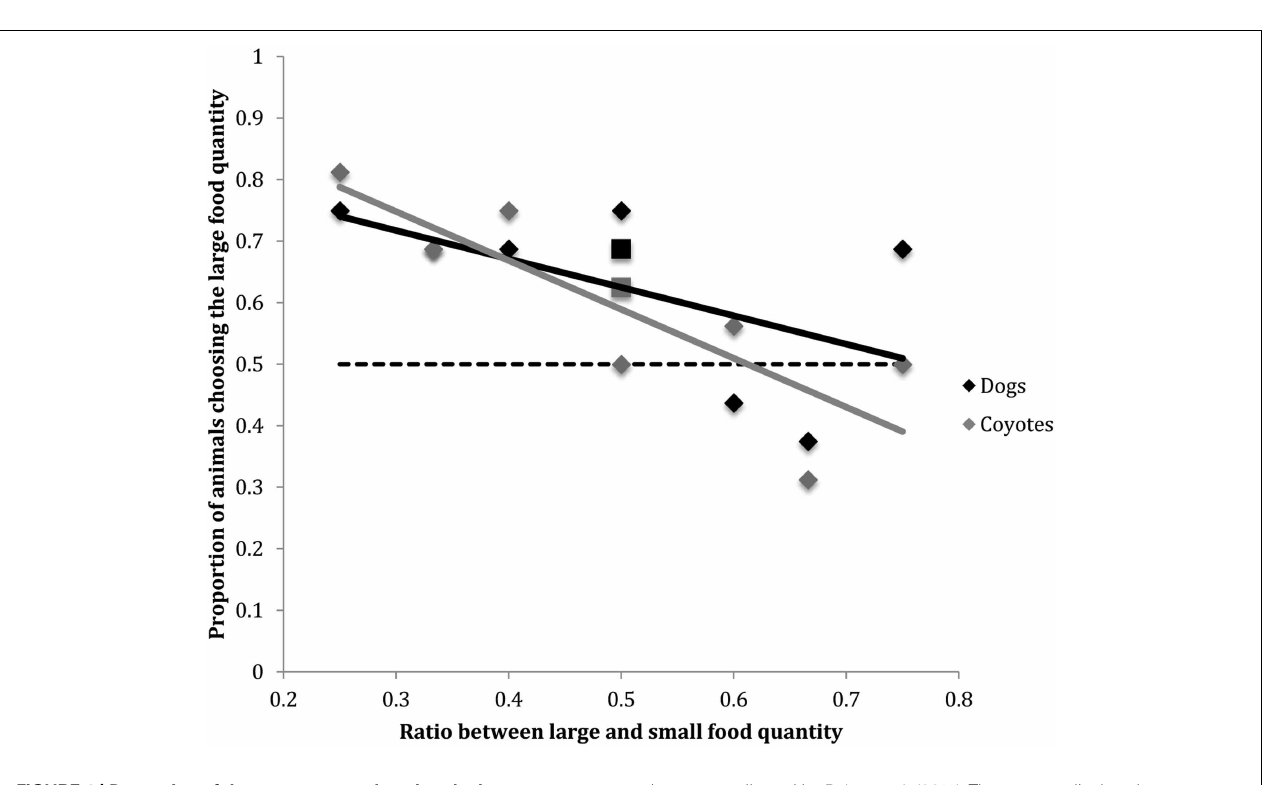
FIGURE 1 | Proportion of dogs vs. coyotes choosing the larger food quantity as a function of the ratio between large and small food quantities. Solid lines indicate regression lines (i.e., slopes) for both canid species. Horizontal dashed line indicates chance performance (50%).The negatively sloped regression lines indicate that dog and coyote quantitative choice behavior becomes more random as the ratio between food options approaches 1:1. Coyote